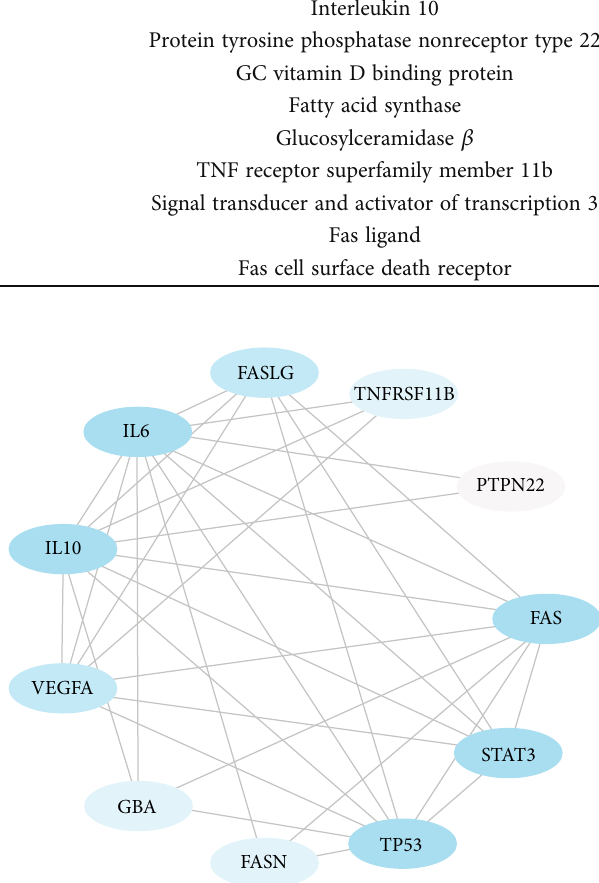
Figure 3: Protein-protein interactions of SSd-HT